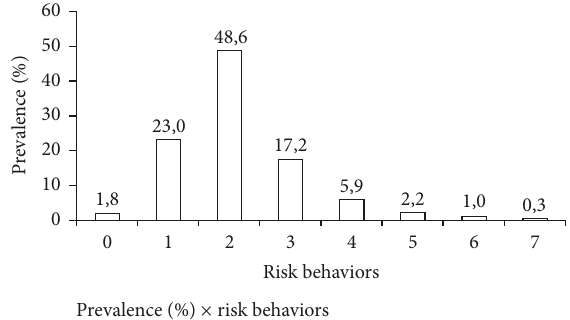
Figure 1: Prevalence of risk behaviors in adolescents in the geoeco- nomic region of Aracaju, State of Sergipe,